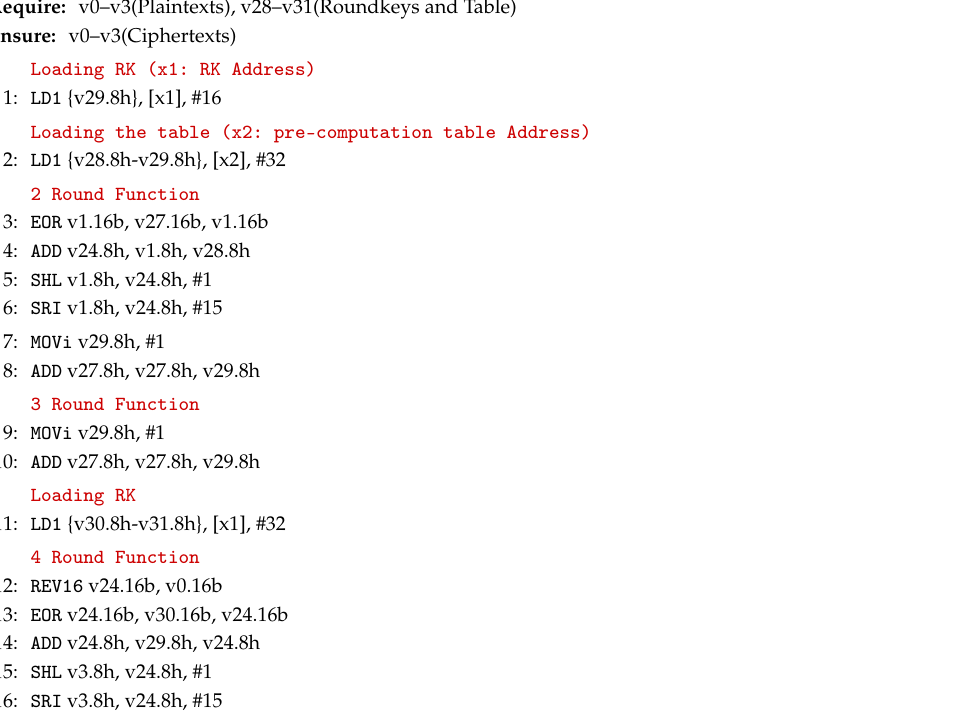
Algorithm 7 Parallel implementation of the revised CHAM-64/128-CTR mode optimiza-